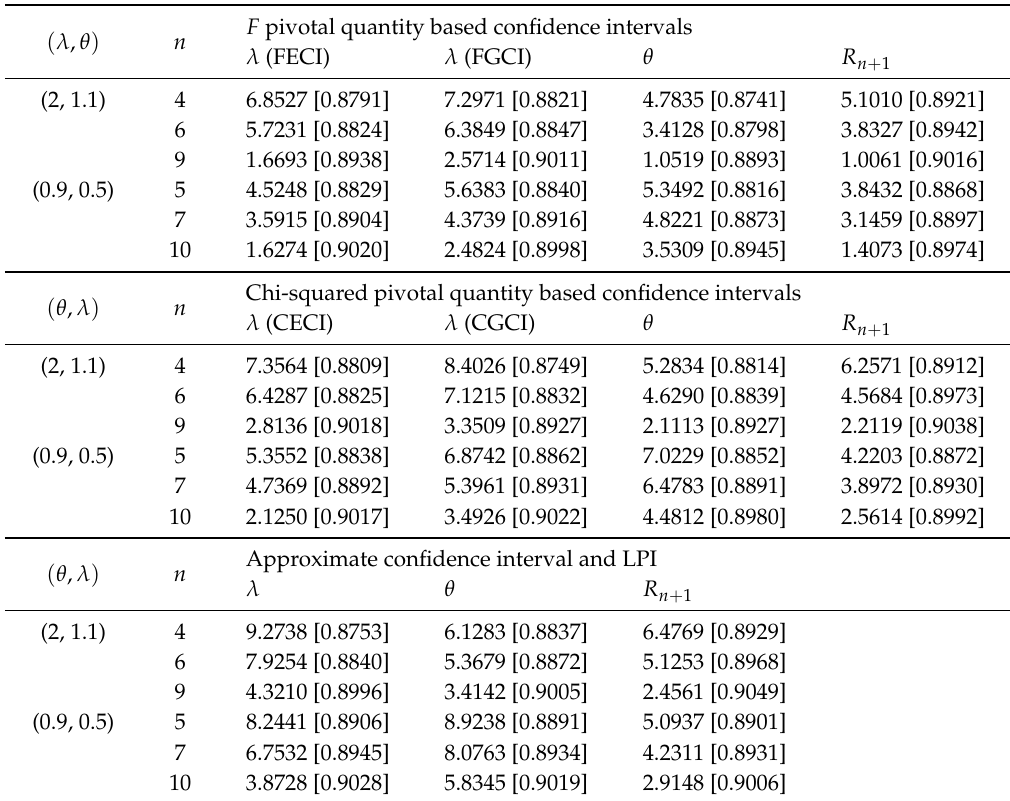
Table 1. AWs and CPs (within bracket) of interval estimates for GIED